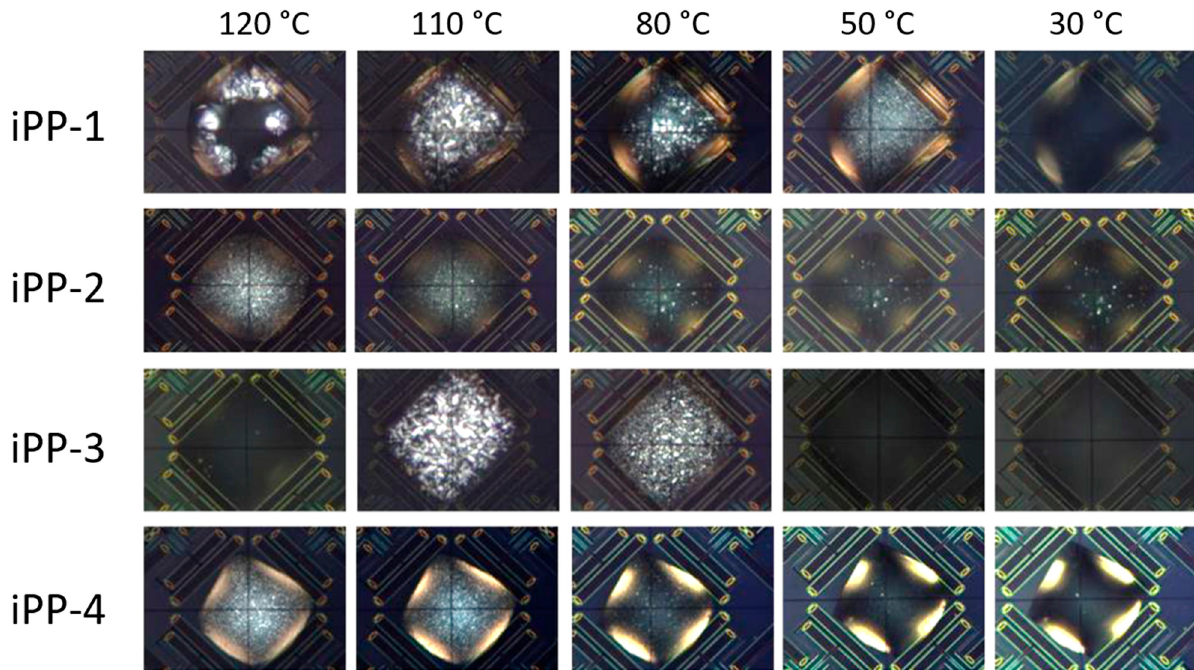
Figure 8. Micrographs of iPP homo- and copolymers at different isothermal crystallization temperatures analyzed by fast scanning chip calorimetry (FSC).